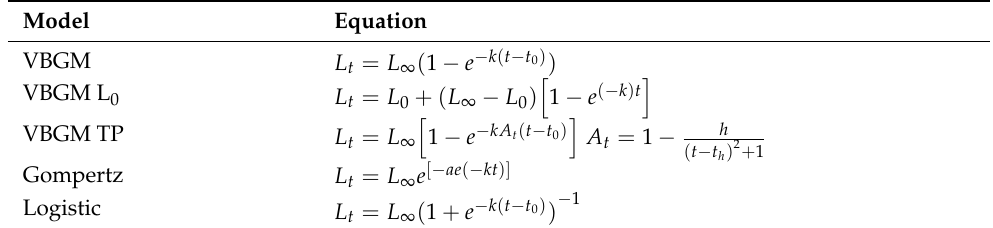
Table 1. Growth models adjusted for length and